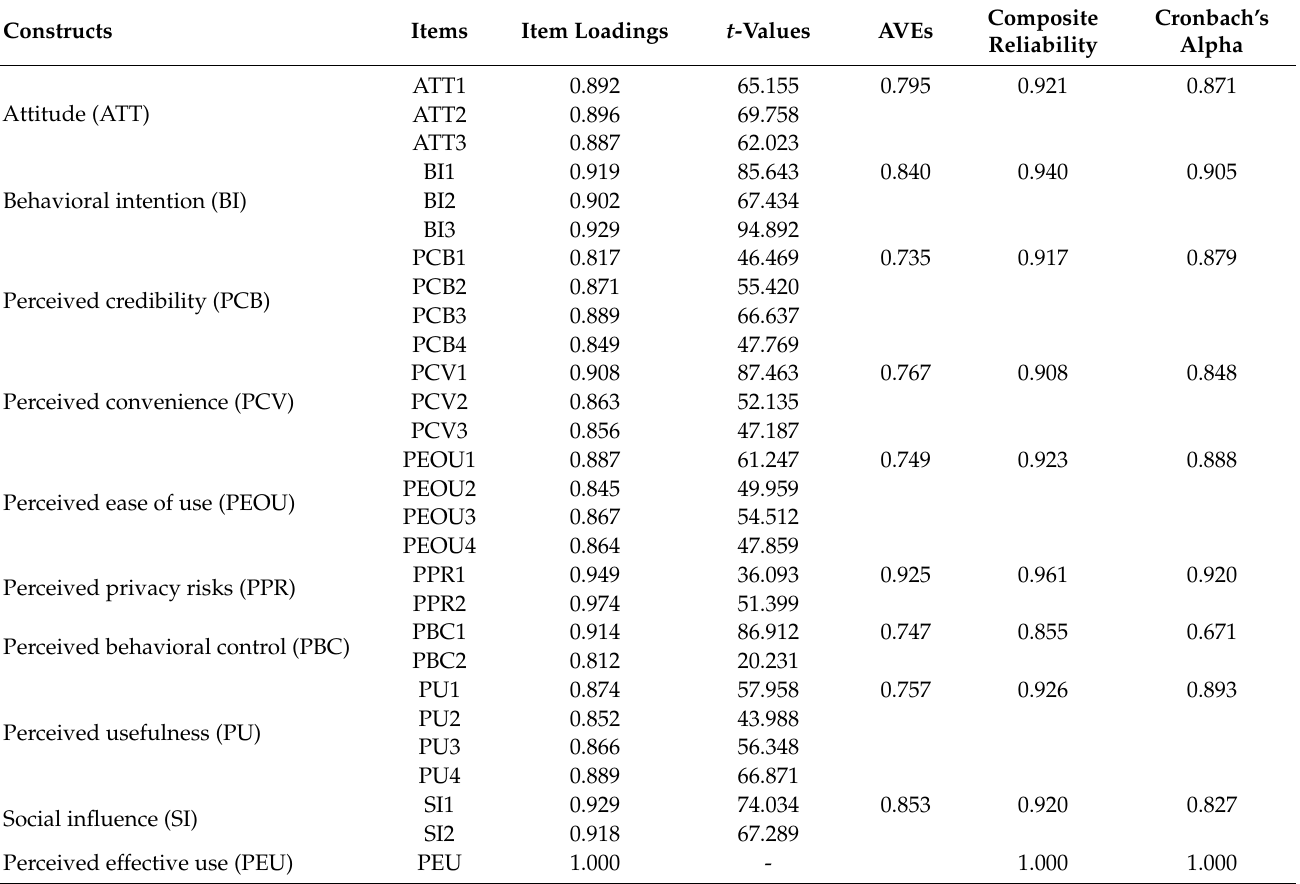
Table 4. Reliability and convergent validity of the